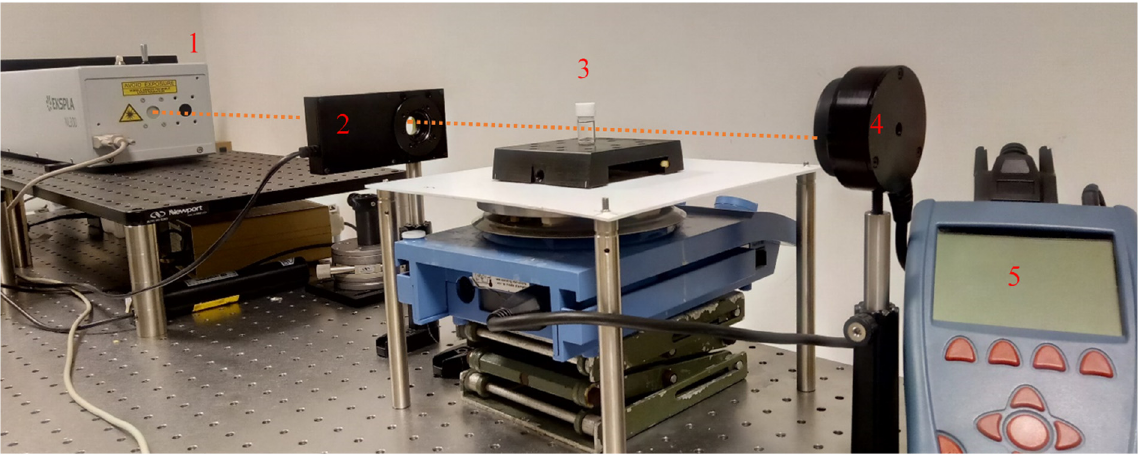
Figure 1. Experimental setup used for NPLIN experiments: 1—laser; 2—quarter-wave plate; 3—sample; 4—sensor; 5—power meter.